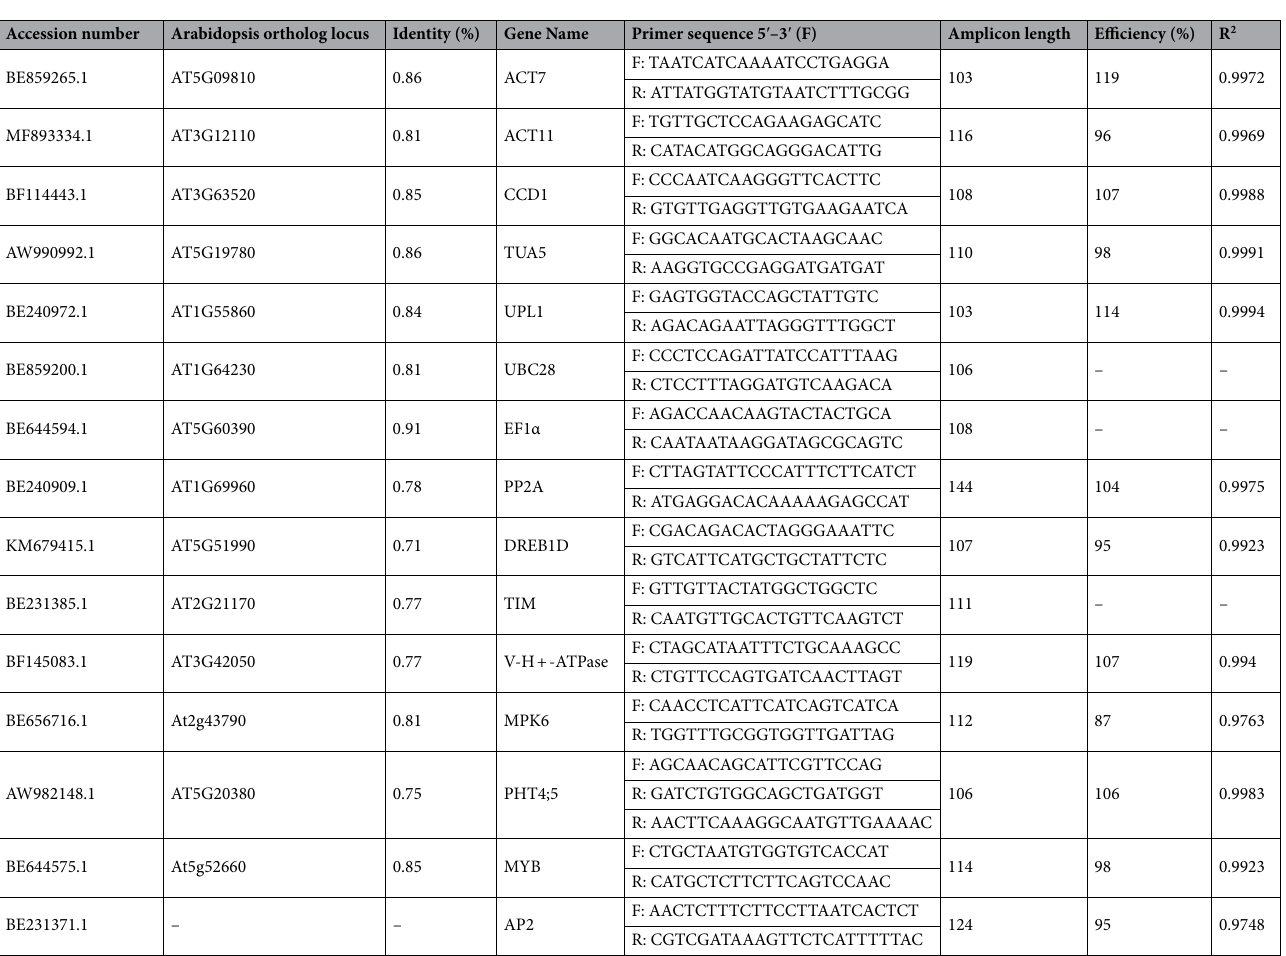
Table 1. Primer sequences and amplification characteristics of candidate reference genes of S. glauca used in this study. Amplicon length was obtained using cDNA as a